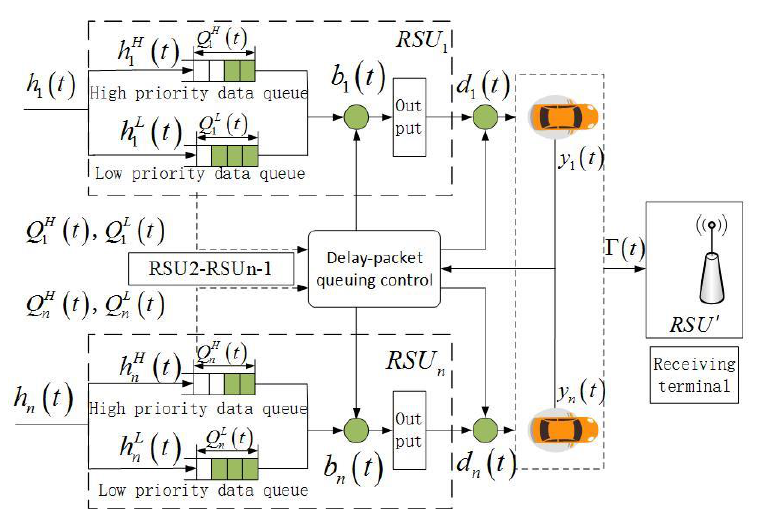
Figure 2. Packet scheduling